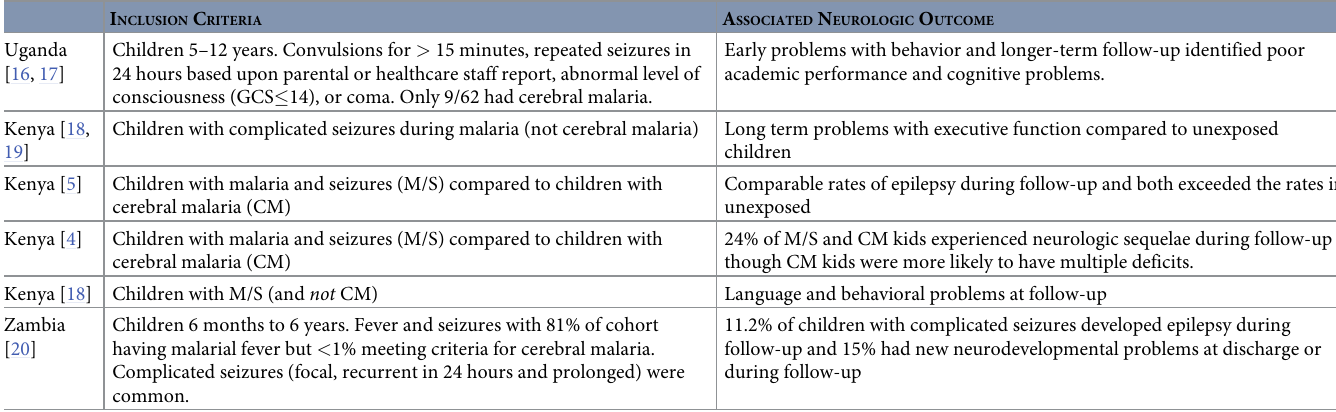
Table 1. A Review of neurologic outcomes after CNS